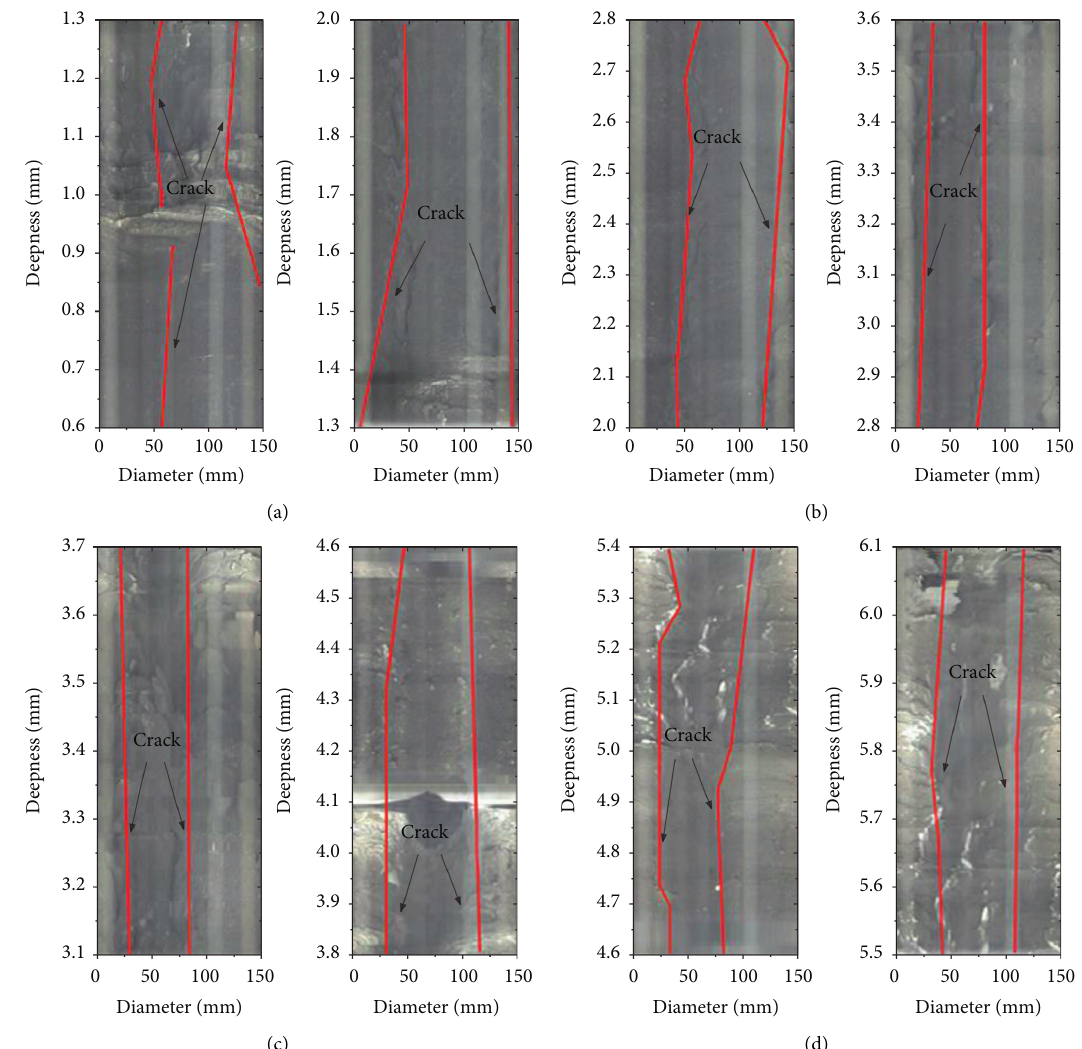
Figure 14: Crack propagation in the hole after blasting. (a) The first binding energy tube. (b) The second binding energy tube. (c) The third binding energy tube. (d) The fourth binding energy